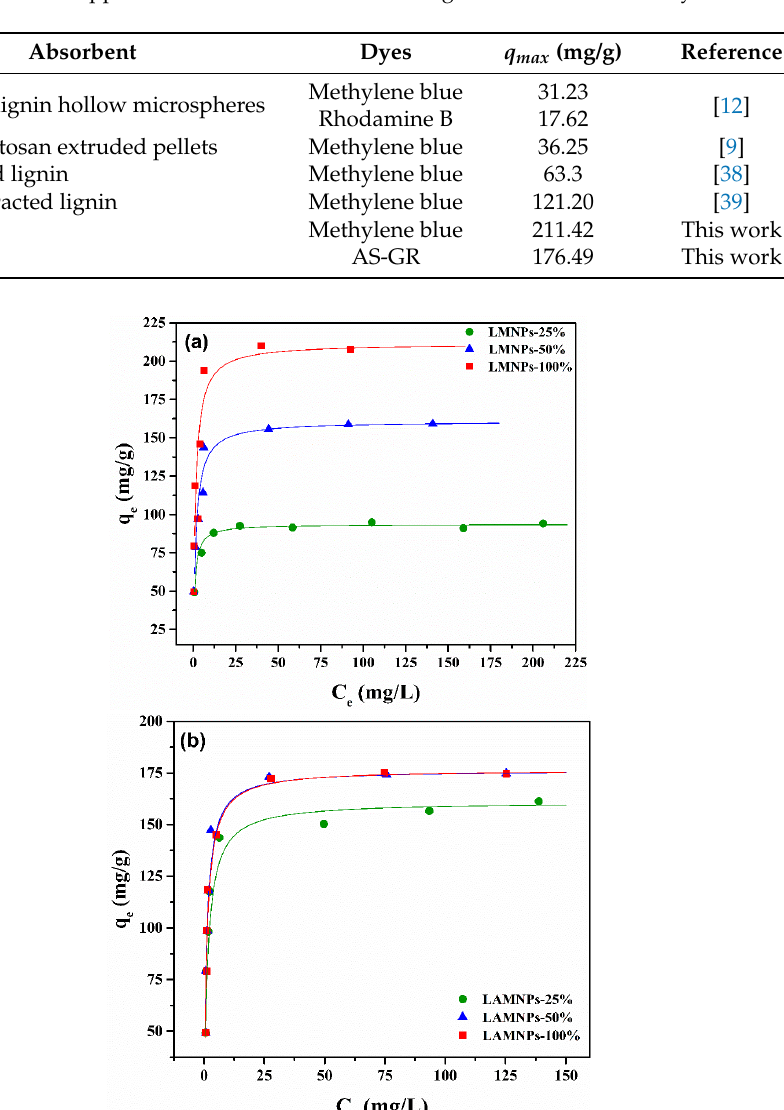
Table 4. Application of adsorbents based on lignin in the removal of dyes.